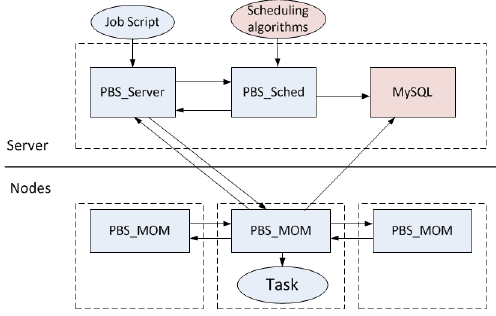
Figure 6. The TORQUE-based parallel framework